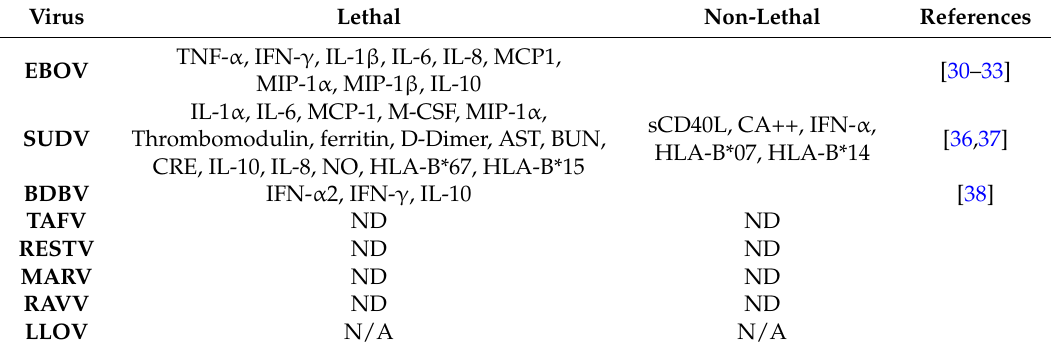
Table 2. Cytokine responses and human genes associated with lethal vs. non-lethal filovirus infections in humans. Virus Lethal